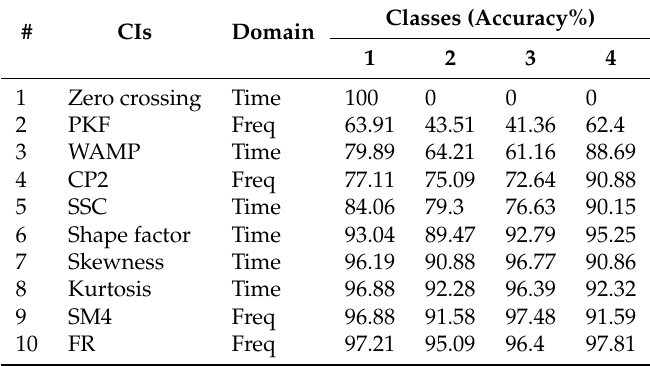
Table 8. Accuracy per class to CI_TFL (time and frequency domain).